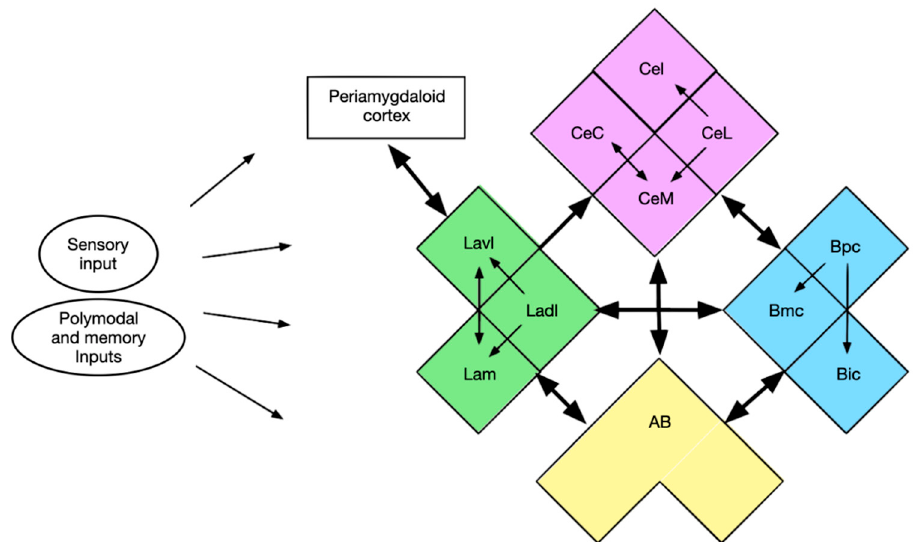
Figure 6. Intra-amygdaloid links (Green—LA: Lavl–ventrolateral subdivision, Ladl—dorsolateral subdivision, Lam—medial subdivision; Purple—central nucleus: CeC—capsular subdivision, CeM—medial subdivision, CeL—lateral subdivision, CeI—intermediate subdivision; Blue—basal nucleus: Bpc—parvicellular subdivision, Bmc—magnocellular subdivision, Bic—intermediate subdivision; Yellow—accessory basal nucleus—AB).